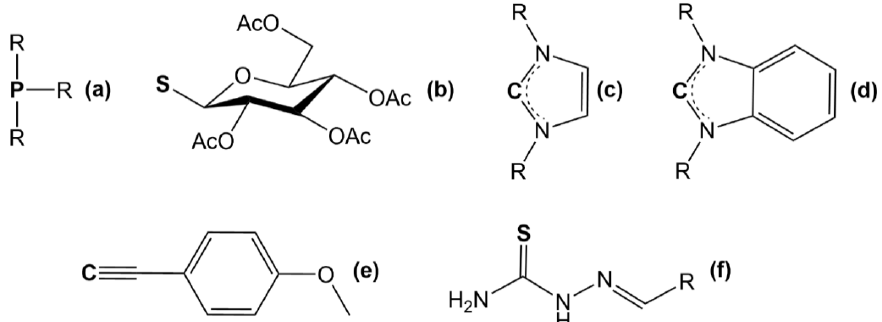
Figure 2. Most common ligands in Au(I) antitumor complexes: phosphine with R = Ph, Me, Et ( a ); thiosugar ( b ); NHC complexes imidazol-2-ylidene ( c ) and benzimidazol-2-ylidene with R = Me, Et ( d ); alkynyl ( e ); thiosemicarbazone ( f ) with R = phenyl, p -methoxyphenyl, thiophene, furan, pyridinyl, and p -hydroxyphenyl. Atoms directly bound to Au(I) are in bold.